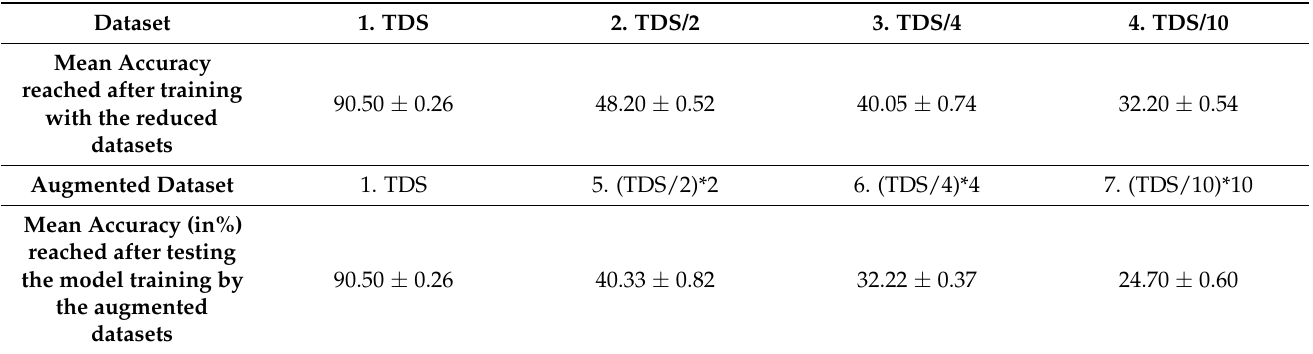
Table 9. Experiment-3: Performance comparison; TDS is the original dataset where 100 graphs are for training and 50 graphs for testing. The Numerical Augmentation ratio is Dataset × Augmentation-scale.